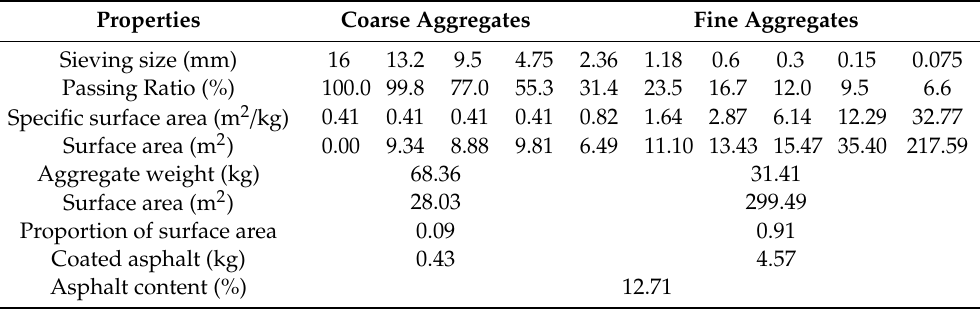
Table 2. Calculation of the asphalt content of the asphalt